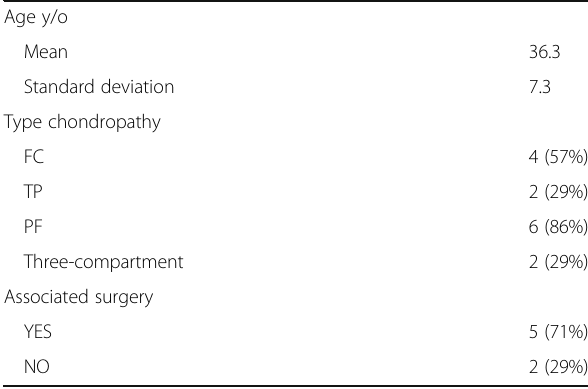
Table 1 Background data of the failures ( n =